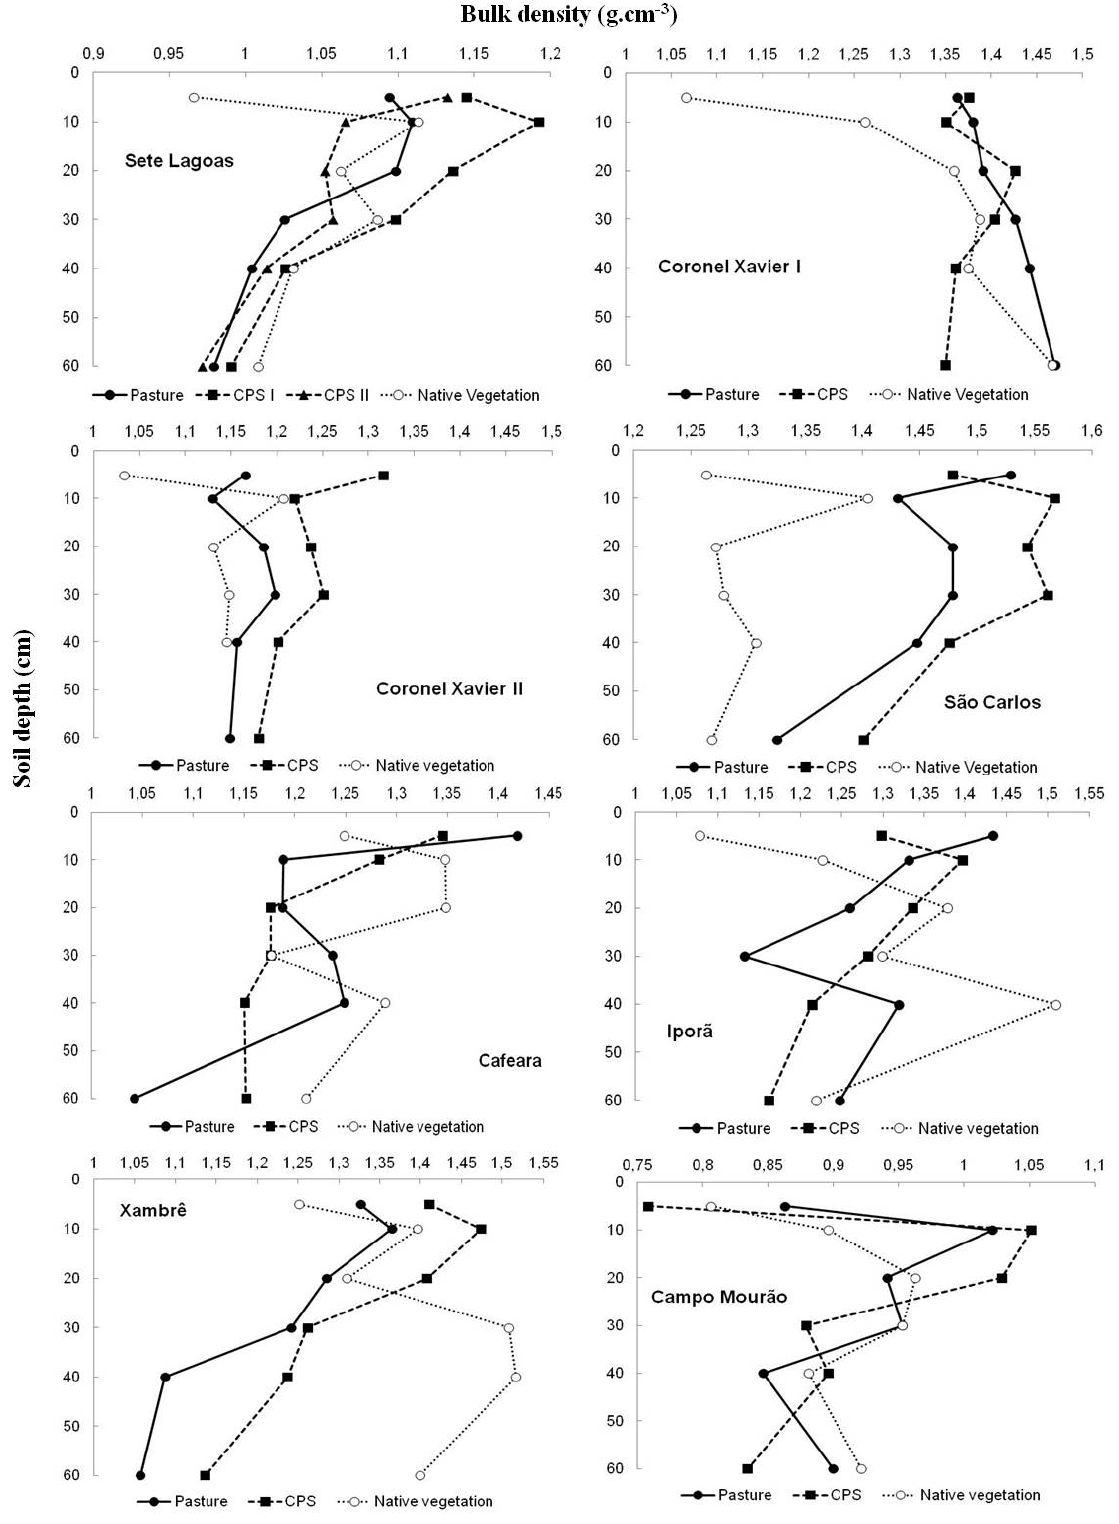
Fig. A1. Soil depth variability of soil bulk density in different land uses. TS5